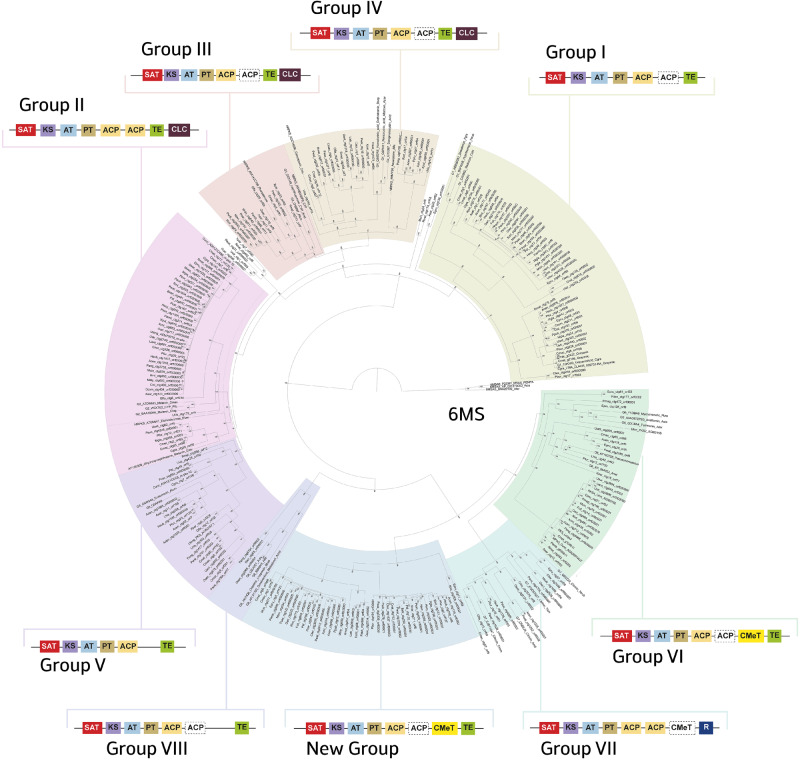
Gene tree of NR-PKS dataset inferred by ML analysis in IQ-Tree using 6 Methylsalicylic PKS protein sequences as outgroup. The distinct colors represent the different groups corresponding to the domain arrangement. In each group the domain arrangement of NR-PKS is highlighted with distinct colors. SAT = starter unit-ACP transacylase, KS = ketosynthase, AT = acyl transferase, PT = product template, ACP = acyl carrier protein, TE = thioesterase, TE/CLC = thioesterase/Claisen cyclase, CMeT = C-methyltransferase, R = reductase.